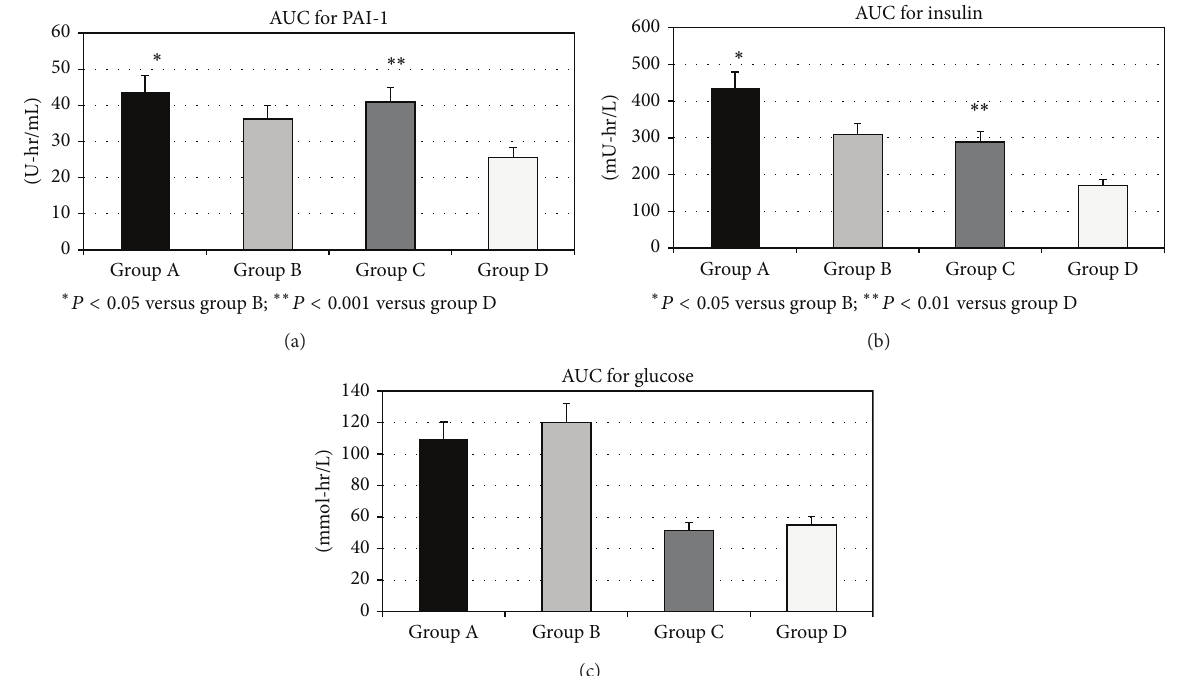
Figure 3: The value of area under the curve (AUC) for daily profile of PAI-1 activity (a), plasma insulin (b), and plasma glucose (c) levels in T2D patients with CAD (group A), T2D without CAD (group B), nondiabetics with CAD (group C), and healthy controls (group D). 𝑃 values indicate the statistical significance of the difference across the groups, as estimated by ANOVA with post hoc Bonferroni test. Data are means ±